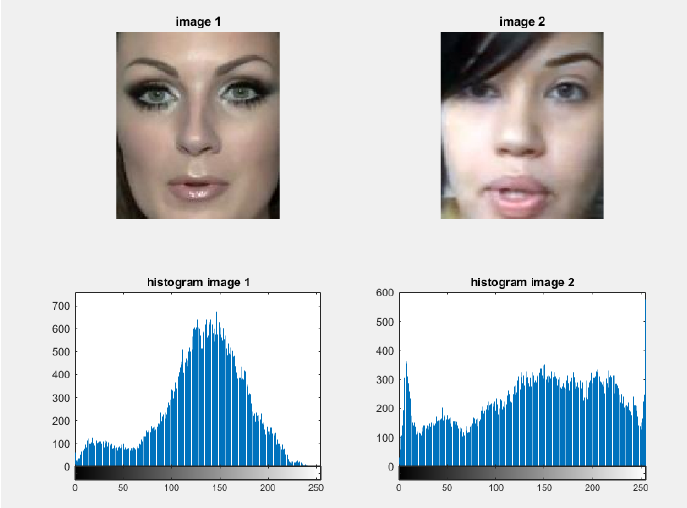
Figure 11. Histogram of Testing Image.